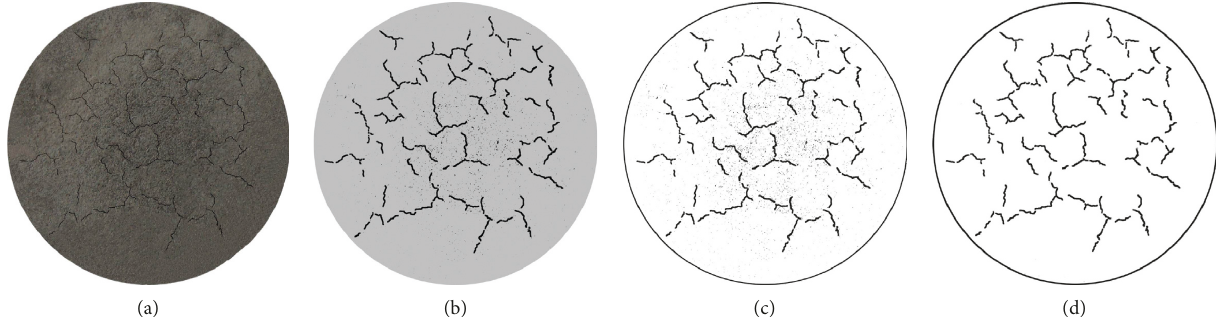
Figure 4: Main steps for processing the image that contained cracks. (a) Original image. (b) Grayscale image. (c) Binarized image. (d) Spot- removed image.